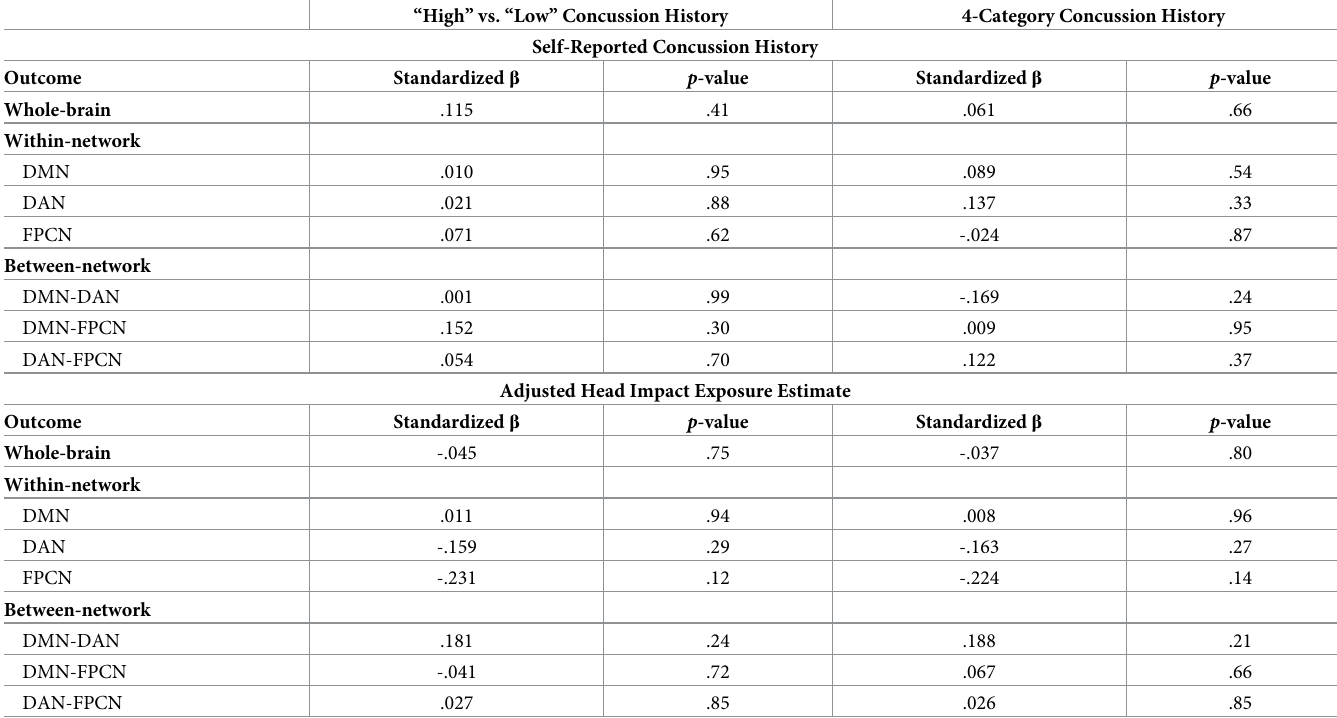
Table 3. Standardized β -values from multivariable linear regression